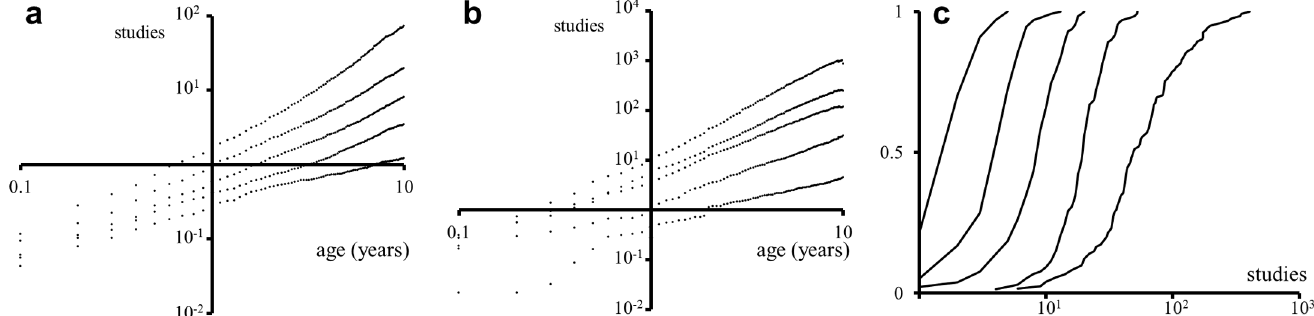
Fig 2. Average cumulative number of studies for drugs born during the period 1990 – 2010. (a) Clinical , (b) Literature . Each of the five trends in each chart corresponds to a quintile of the dataset, with the most studied drugs at the top and the least studied at the bottom (excluding the first study for each drug). The abscissa represents the age of the drug in years. As would be expected, the value of β increases for each quintile in each dataset. To construct the quintiles, drugs born in the same year were treated as a cohort. Each drug within a cohort was sorted into a quintile according to the number of studies it had accumulated by 2010. Thus, for example, drugs born in 1998 were compared only to drugs born in 1998 and not to older or newer drugs. Drugs studied only once were excluded. Regression curves for every trend were power laws with, respectively, the following β and R 2 values, from upper quintile to lower quintile: (a) Clinical , β = {1.52, 1.25, 1.11, 1.09, 0.69} and R 2 = {0.98, 0.99, 0.99, 0.93, 0.96}, (b) Literature , β = {1.95, 1.59, 1.45, 1.29, 1.13} and R 2 =